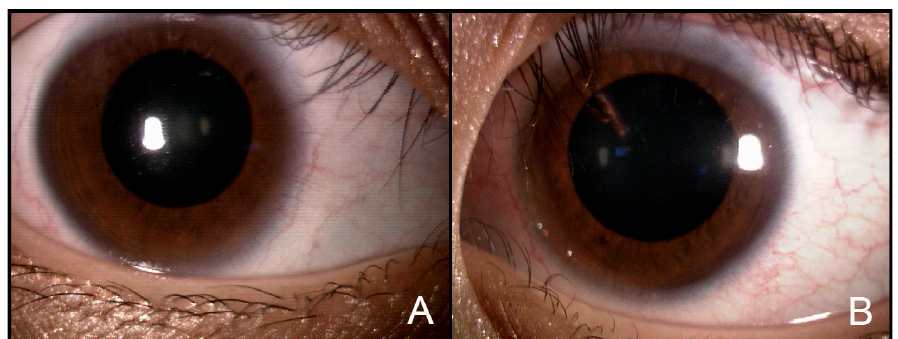
Figure 1. Photograph of the anterior segment of the right and left eyes. There is no evidence of a blue sclera, corneal opacities, or cataracts in either eye (( A ): right eye, ( B ): left eye). Fundus examinations detected an RRD in the nasal and inferior quadrants that was located near the macula and was associated with an atrophic hole in the inferonasal quadrants and lattice degeneration in the temporal quadrants. The posterior vitreous was not detached. Fundus autofluorescence (FAF) examinations showed a hypo-FAF area corresponding to the RRD and hyper-FAF lesions corresponding to the subretinal fibrosis.